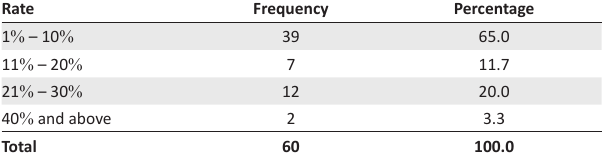
TABLE 6: Commission percentage.